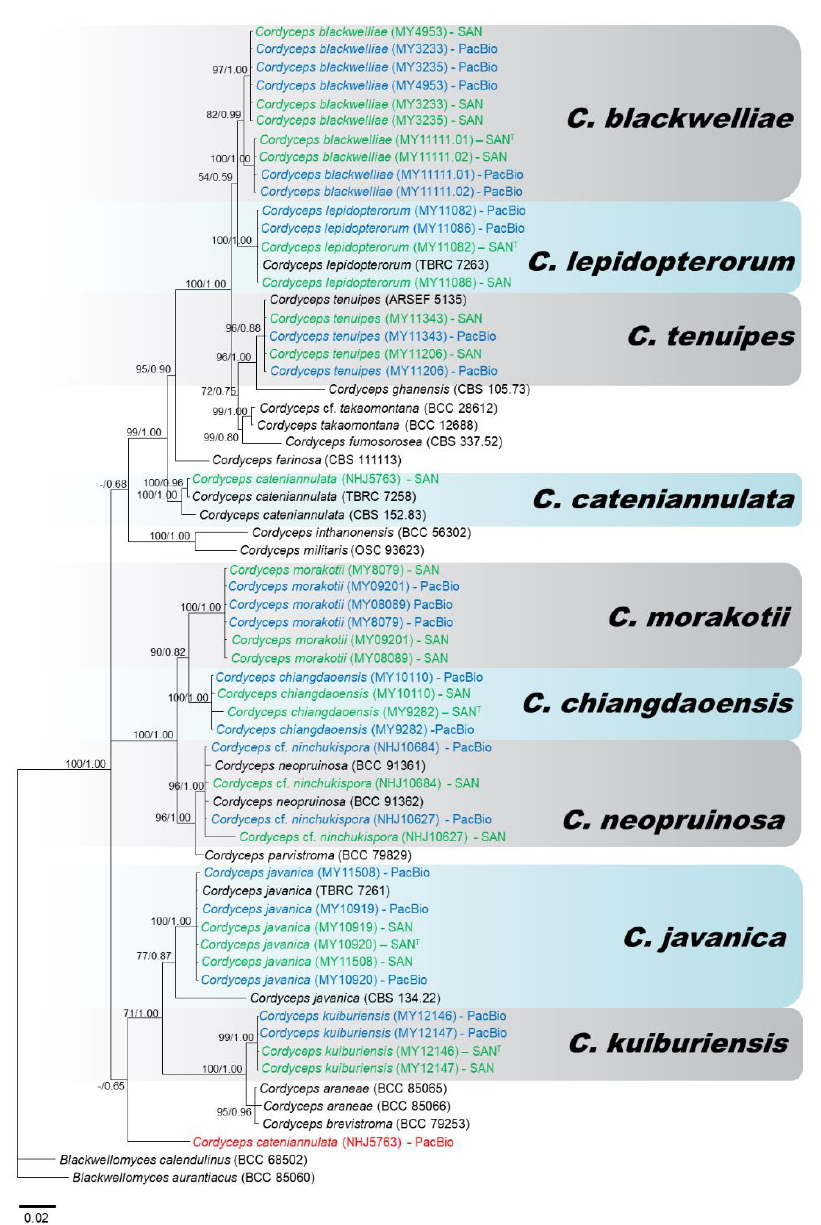
Figure 4. Consensus phylogram (50% majority rule) from a Bayesian analysis of the nrITS-nrLSU combined sequences, obtained from 10 6 MCMC generations. Maximum likelihood bootstrap values >50% (left of/) and Bayesian posterior probabilities >0.50 (to the right). The scale bar represents substitution rate per site. The PacBio cluster sequences highlighted in blue are those clustered within corresponding true species clades; other PacBio cluster sequences highlighted in red are those branched outside the species of origin. All Sanger sequences of the studied strains are highlighted in green. Sanger sequences of type species demarked as ‘T’.